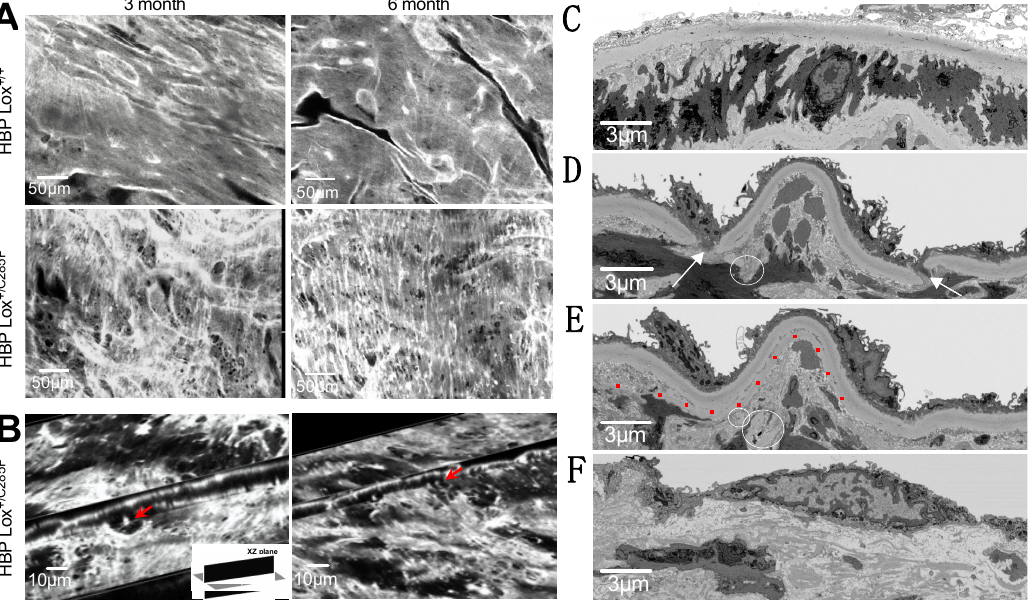
Figure 5. Increased fenestrations in Lox +/C285F elastic lamellae. ( A ), En-face two-photon imaging shows smooth and regular IEL in Lox +/+ (top) while Lox +/C285F are irregular and less tightly woven with numerous obvious fenestrations (bottom) See Supplemental Figure S1 for images of the second lamella). Representative images, n = 3. ( B ), Still images demonstrate fenestrae in 3D by crossing XY (10 μ m) and XZ (5 μ m) planes of the images in Lox +/C285F mice (see also Supplemental Videos S1–S6).